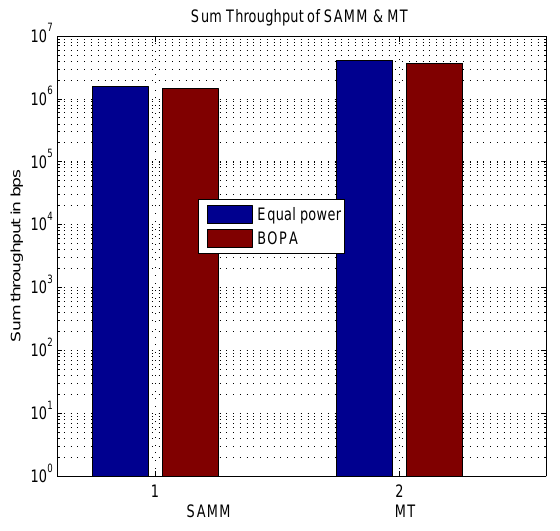
Figure 3. Sum throughput of all